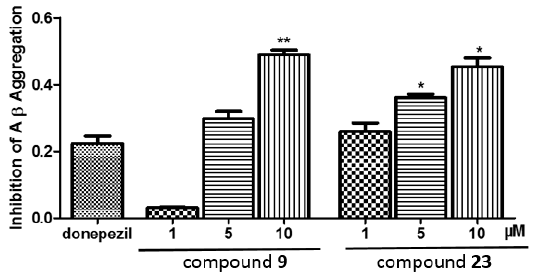
Figure 5. Inhibitory activity against A β 1-42 produced by 9 (1, 5, 10 µ M), 23 (1, 5, 10 µ M), and donepezil (10 µ M). Data are shown as mean ± SD ( n = 3), with * p < 0.05 and ** p < 0.01 versus donepezil.